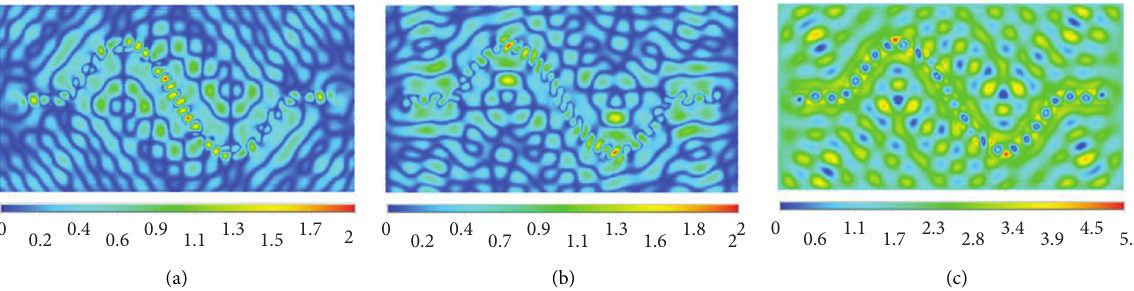
Figure 16: P wave incident ( f � 3.0Hz, H � 100m, C